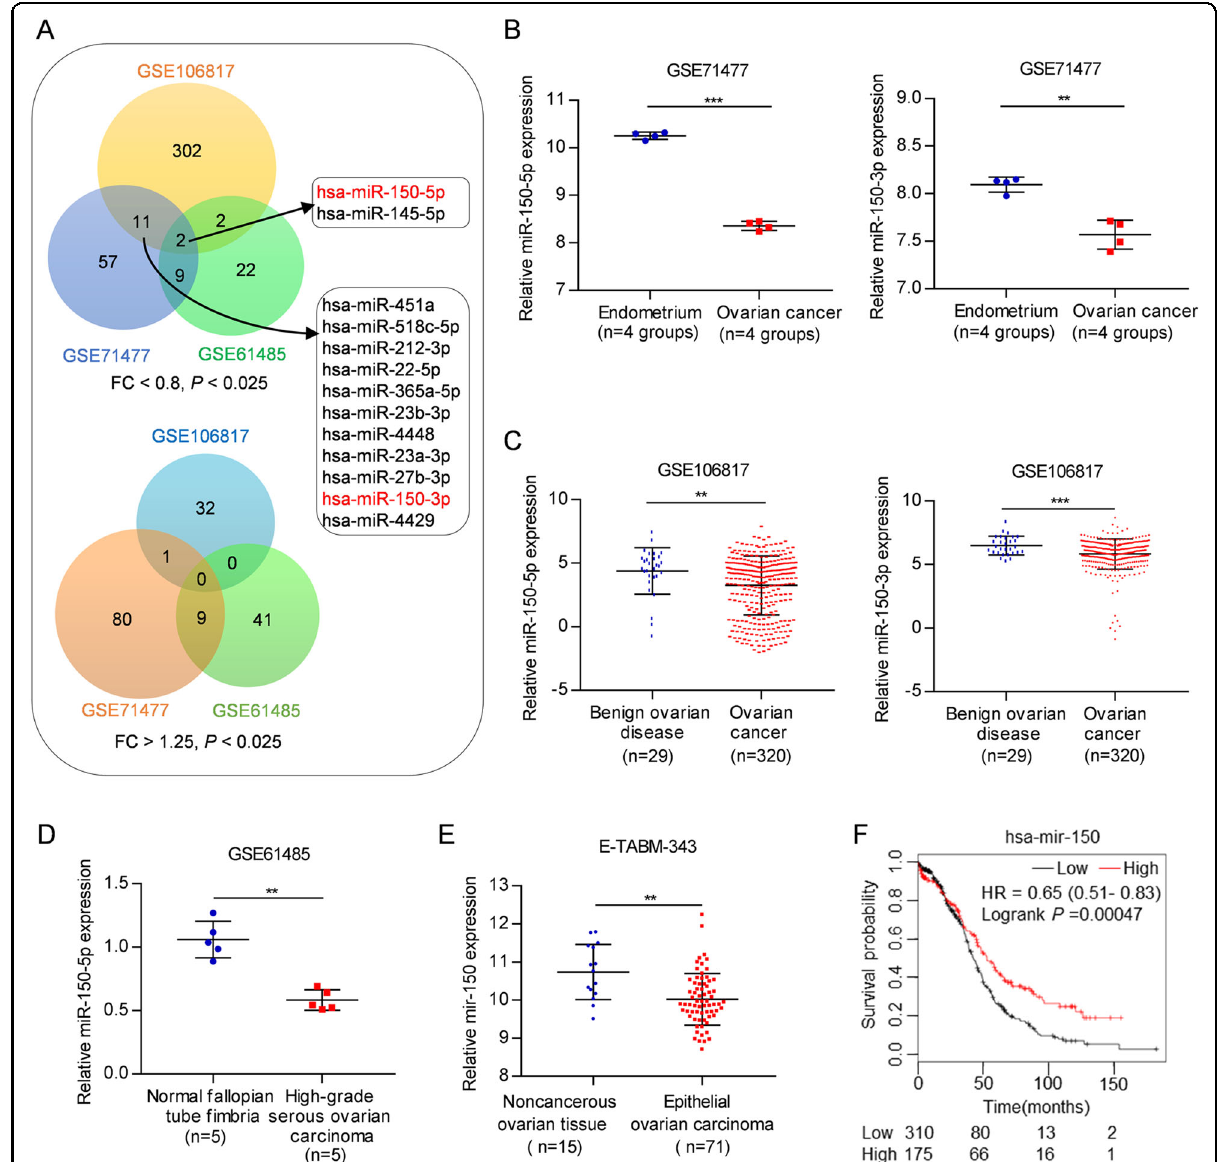
Fig. 1 miR-150-5p/3p are downregulated in OC. A Dysregulated miRNAs in OC compared with the corresponding control in GSE71477, GSE106817, and GSE61485 datasets (FC <0.8 or >1.25, P < 0.025). B – D Expression of miR-150-5p and miR-150-3p was signi fi cantly downregulated in OC compared with those in the endometrium (GSE71477) ( B ), benign ovarian disease (GSE106817) ( C ), or normal fallopian tube fi mbria (GSE61485) ( D ). E The levels of miR-150 precursor (mir-150) were also reduced in OC compared with noncancerous ovarian tissues (E-TABM-343). F Kaplan – Meier survival curves for OC patients according to mir-150 expression levels in tumor tissues; signi fi cance was calculated using log-rank test. The data are presented as the mean ± s.d. ** P < 0.01, *** P < 0.001 by Wilcoxon signed-rank test or Mann – Whitney U